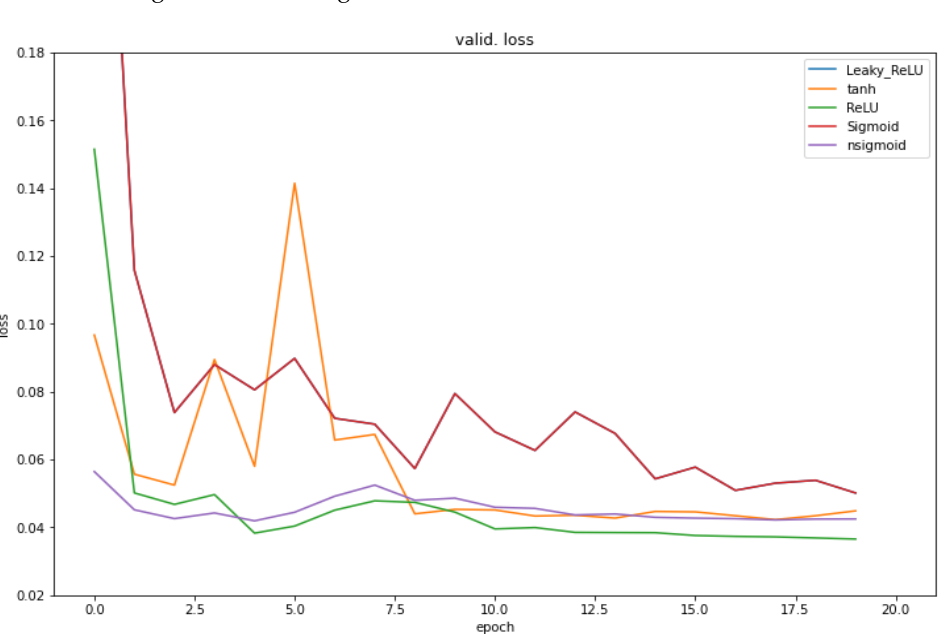
Figure 6. Comparison of the validation loss of the convolutional neural network (CNN) training for all the activation functions.